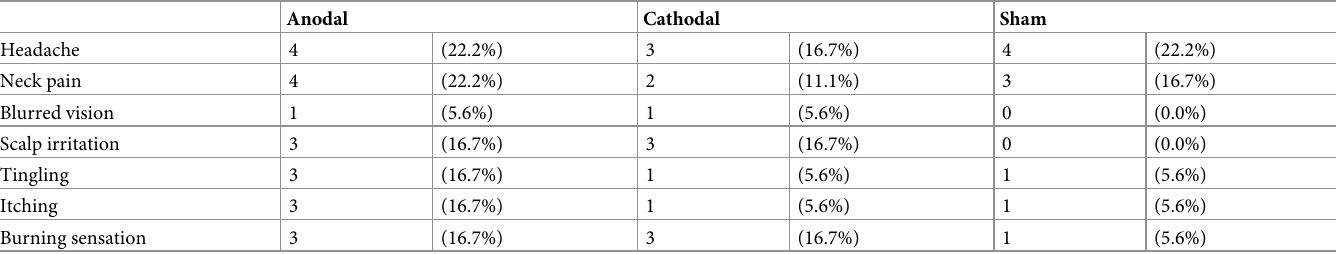
Table 2. Incidence of adverse events after stimulation.